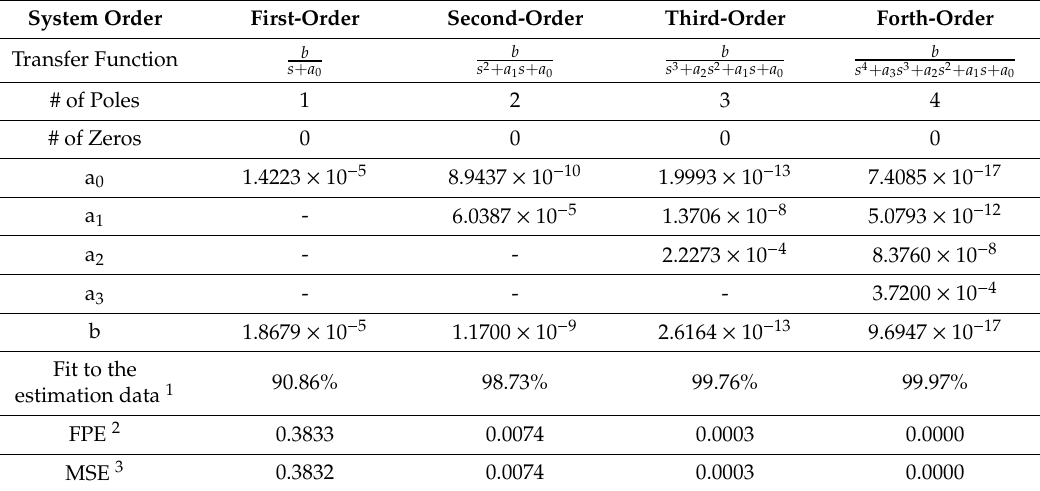
1 Fit to the estimation data: Normalized root mean square error. 2 FPE: Final prediction error for the model. 3 MSE: Mean square error.